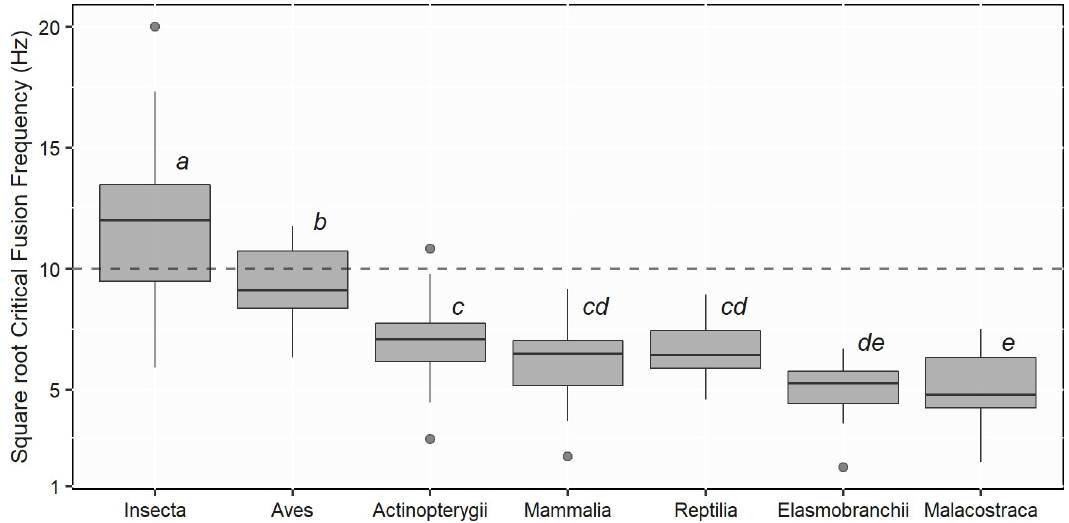
Fig 3. Distribution of square root Critical Fusion Frequencies (CFF) across the most studied taxonomic classes. The dashed line represents the flicker frequency of a lamp on a 50 Hz electrical supply—i.e. 100 Hz. Sample size: Insecta (n = 26), Aves (n = 17), Reptilia (n = 13), Actinopterygii (n = 35), Mammalia (n = 19), Malacostraca (n = 29), Elasmobranchii (n = 12). Linear mixed effect model significant differences (p-value < 0.05) are indicated by the letters above each boxplot.